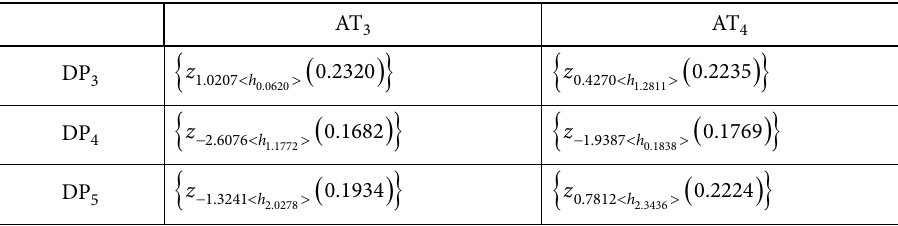
Table 14. The overall decision matrix AT 1 AT